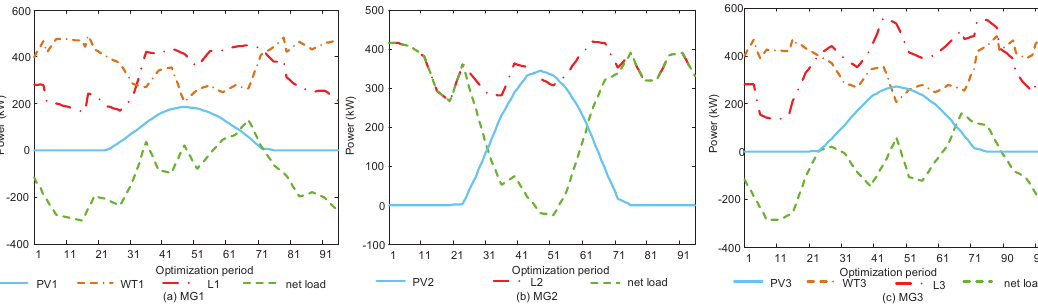
Figure 14. The PV power, WT power and load power in each MG on Day 2 of Scenario 1 (( a ) MG1; ( b ) MG2; ( c ) MG3).